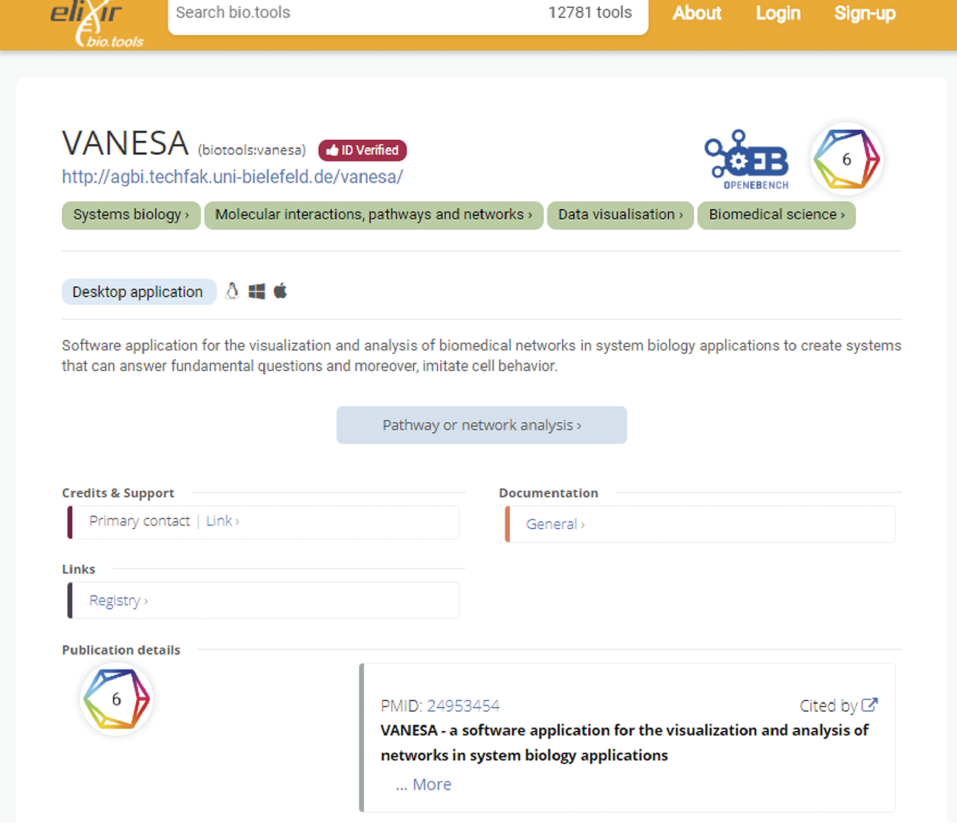
Figure 3: Details page for the “ VANESA ” tool published in the bio.tools